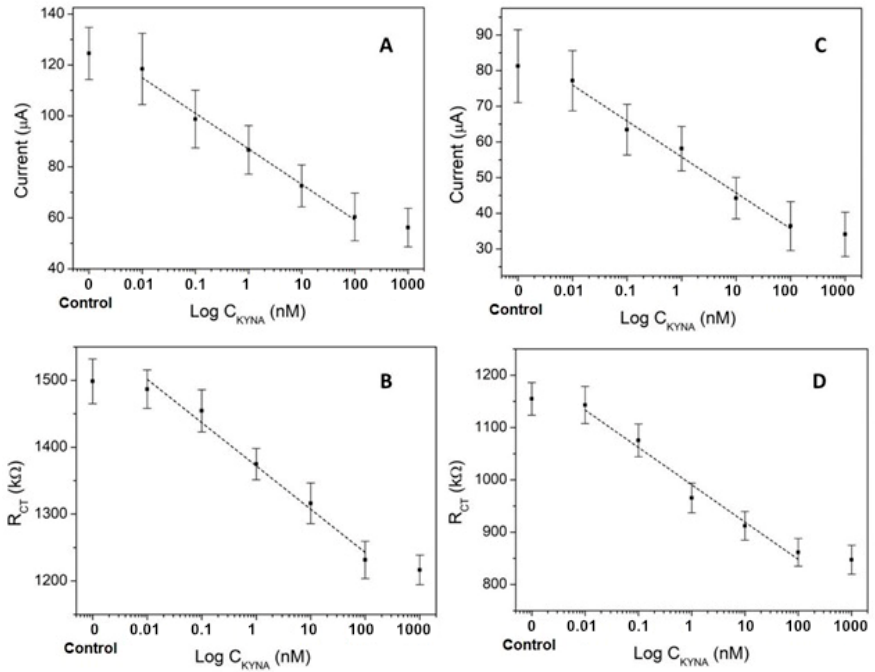
Figure 5. KYNA immunosensor sensitivity test. ( A , B ) Calibration curves in undiluted human serum, using CA and EIS, respectively, and ( C , D ) calibration curves in 1/10 diluted human serum in phosphate-buffered saline (PBS), using CA and EIS, respectively. The concentrations considered were 0, 10 pM, 100 pM 1 nM, 10 nM, 100 nM, and 1000 nM ( n = 5).